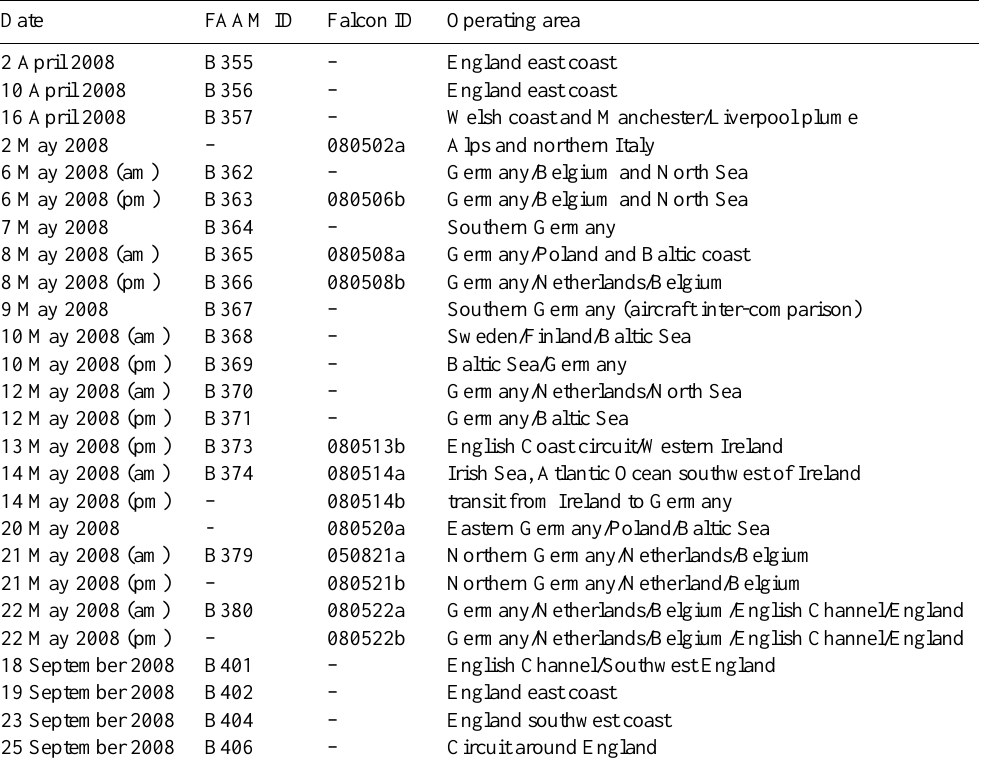
Table 1. Summary of FAAM aircraft flights (with valid SP2 data) during EUCAARI-LONGREX and APPRAISE-ADIENT campaigns and DLR Falcon flights during the EUCAARI-LONGREX